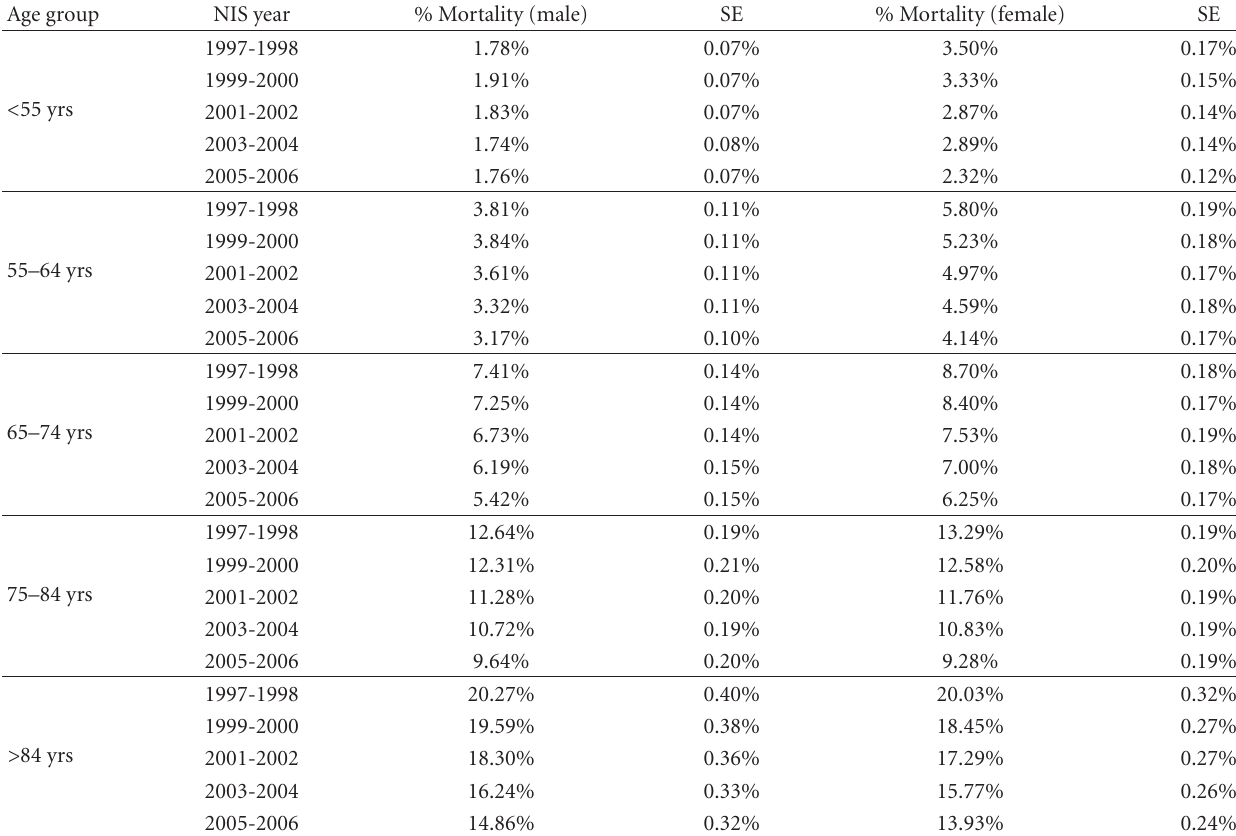
Table 3: In-hospital AMI mortality rate by NIS year, sex, and age group.